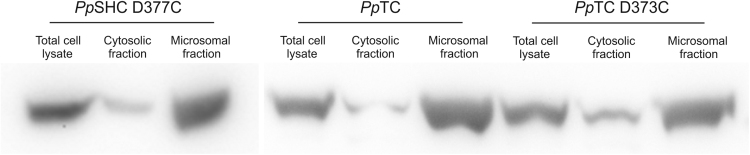
Western Blot analysis using antibodies directed against FLAG-tag of FLAG-SHC D377C and myc-tag of myc-TC and myc-TC D373C in the respective P. pastoris (Pp) expression strains.